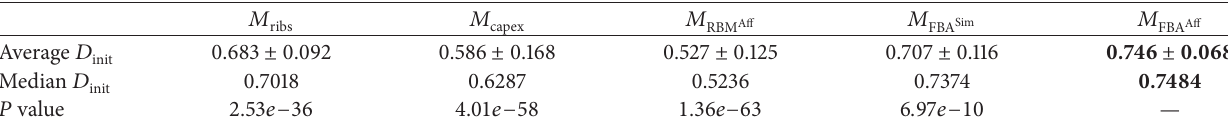
Table 2: Comparison of median and average of initialization accuracy as well as the 𝑃 values of a paired Wilcoxon rank test between each . method and 𝑀 FBA Aff